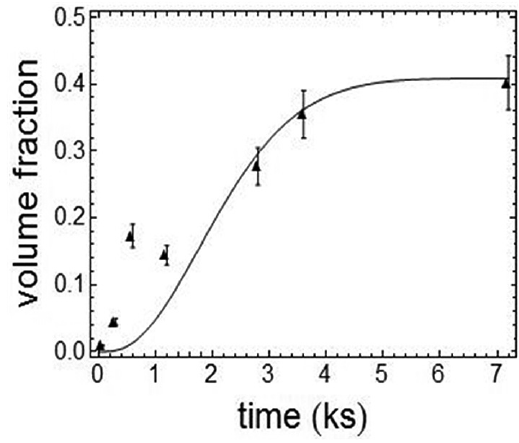
Figure 8. Comparison between volume fraction transformed of other orientations obtained by computer simulation (solid line) and experimental data from Magnusson et al. 2 (filled